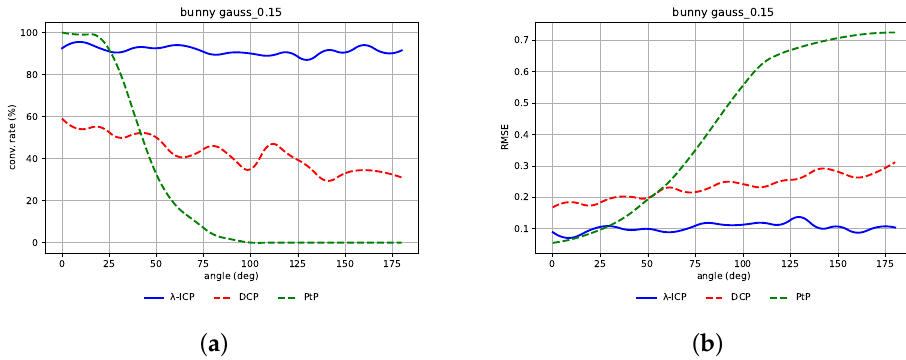
Figure 13. ( a ) Convergence rate of λ -ICP (blue), DCP (red), PtP (green) algorithms for Stanford Bunny with Gaussian noise, σ = 0.15; ( b ) mean RMSE (for transformation matrices) of λ -ICP (blue), DCP (red), PtP (green) algorithms for Stanford Bunny with Gaussian noise, σ = 0.15.